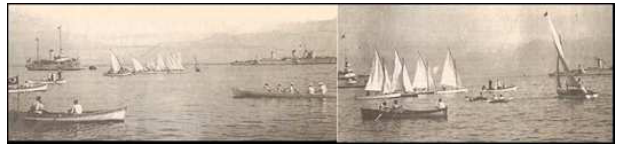
Fig. 2. Sailing as a recreational activity in Izmit Bay in the late 1930s. Photographs obtained from the Izmit Sports Club archive.